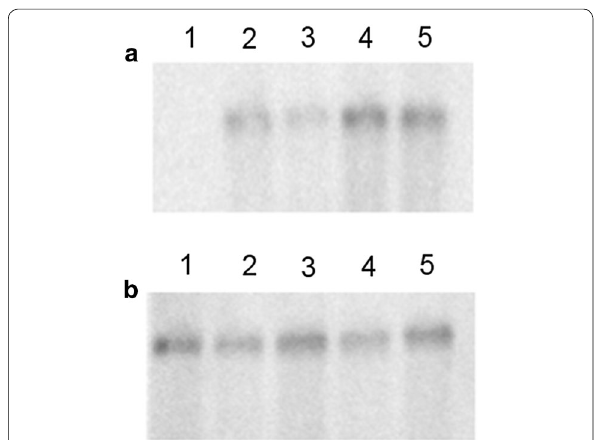
Fig. 2 Transcription analysis of eGFP gene under control of P ADH1 and P PGK1 from JPU and S288C in S. cerevisiae JPU. Total yeast RNA was pre- pared, run in a 1.5% agarose/formaldehyde gel and transferred to a nitrocellulose membrane. The membrane was probed with the eGFP PCR product ( a ) and with the ZWF1 PCR product as loading control ( b ). Lanes: 1 non-transformed cell; 2 Y2JADH; 3 Y2SADH; 4 Y2JPGK; 5 Y2SPGK. The predicted size of eGFP mRNA is approximately 0.7 kb and SWF1 mRNA is ~ 1.5 kb